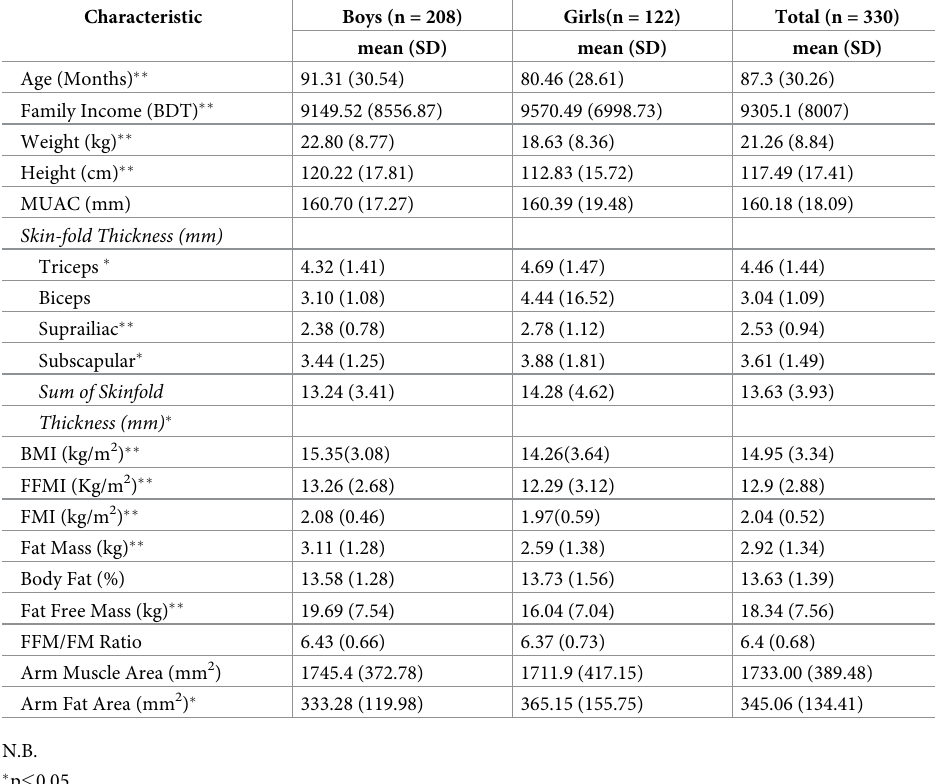
Table 1. Anthropometric and body composition characteristics of children stratified by gender (n = 330).